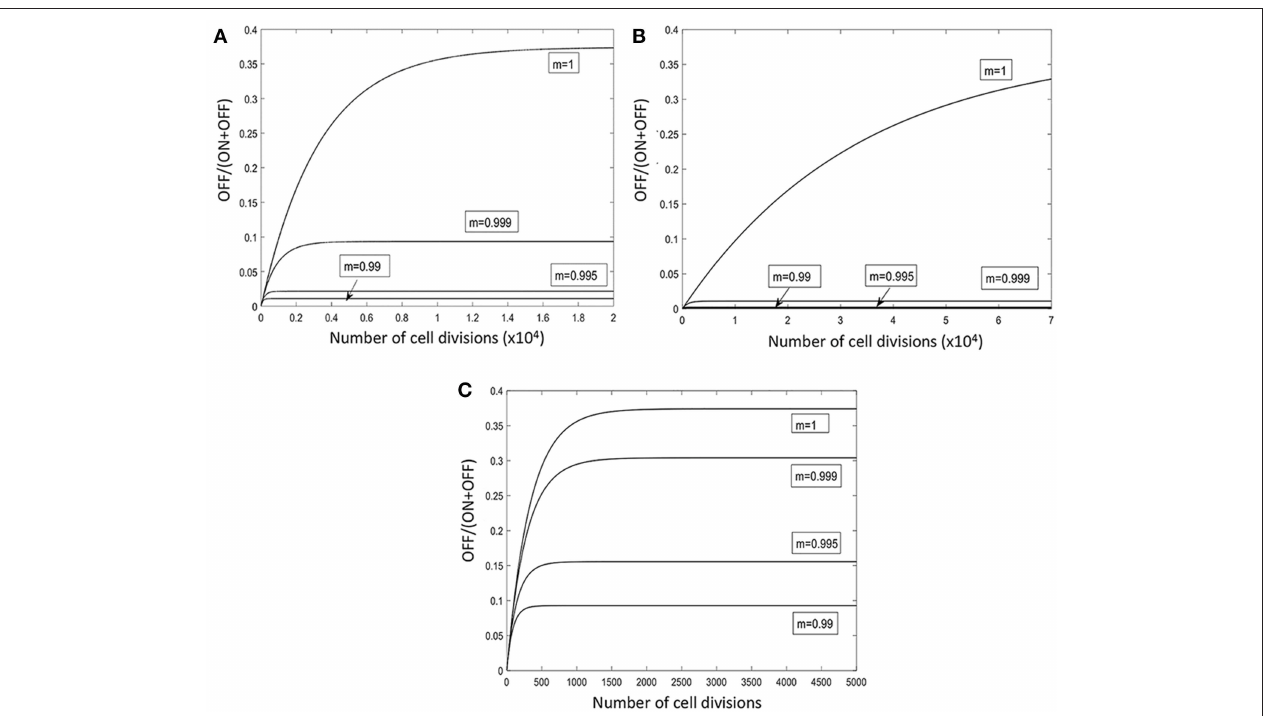
FIGURE 6 | Model of the temporal fluctuations in the relative amounts of phage-susceptible and phage-resistant phase variants for a range of PV rates and selection pressures. PV of the lic2A gene results in switching between phage-susceptible (S, lic2A ON) and phage-resistant (R, lic2A OFF) phase variants. The lic2A ON state is however known to mediate serum resistance (see text). This model examines how the rate of lic2A PV [ α , ON-to-OFF or S-to-R switching; β , OFF-to-ON or R-to-S switching; note that switching rates were obtained from (Dixon et al., 2007)] and the degree of selection ( m ) against the lic2A OFF (i.e., R, the phage-resistant state) expression state influences the relative amounts of the OFF/R and ON/S states in a population. All panels show changes in the proportion of the OFF/R state. Three different switching rates were examined: β = 1.89 × 10 − 4 , α = 1.13 × 10 − 4 (A) ; β = 1.89 × 10 − 5 , α = 1.13 × 10 − 5 (B) ; β = 1.89 × 10 − 3 , α = 1.13 × 10 − 3 (C)